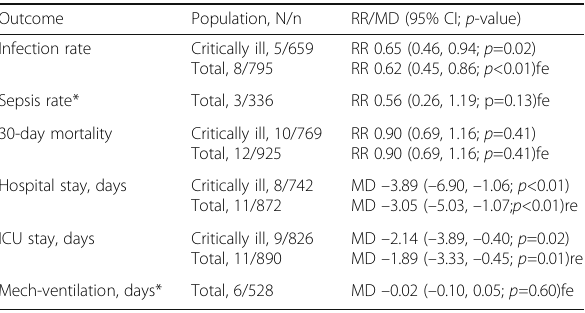
Table 1 (abstract 000600). Results for clinical outcomes Outcome Population, N/n